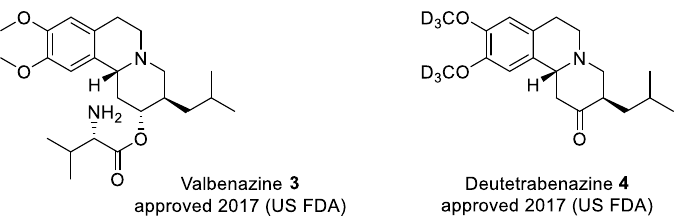
Figure 3. The structures of valbenazine and deutetrabenazine. Figure 3 . The structures of valbenazine and deutetrabenazine.